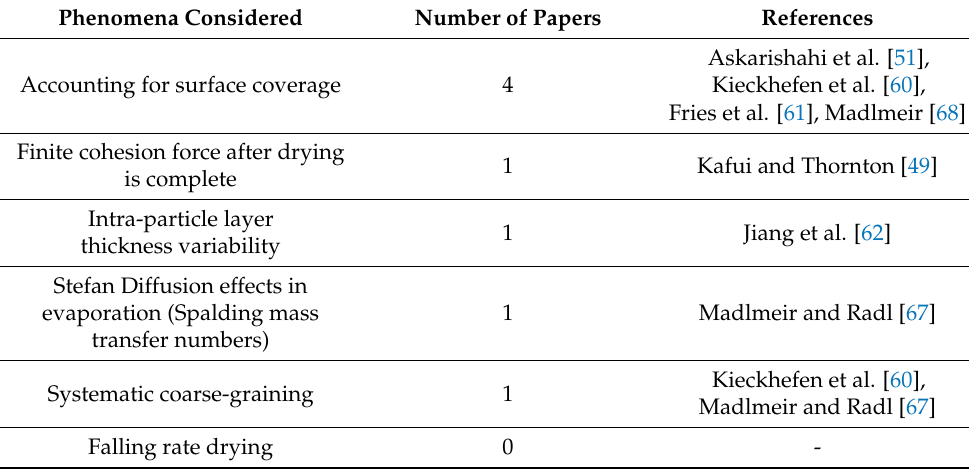
Table 3. Phenomena to be considered in CFD-DEM-based